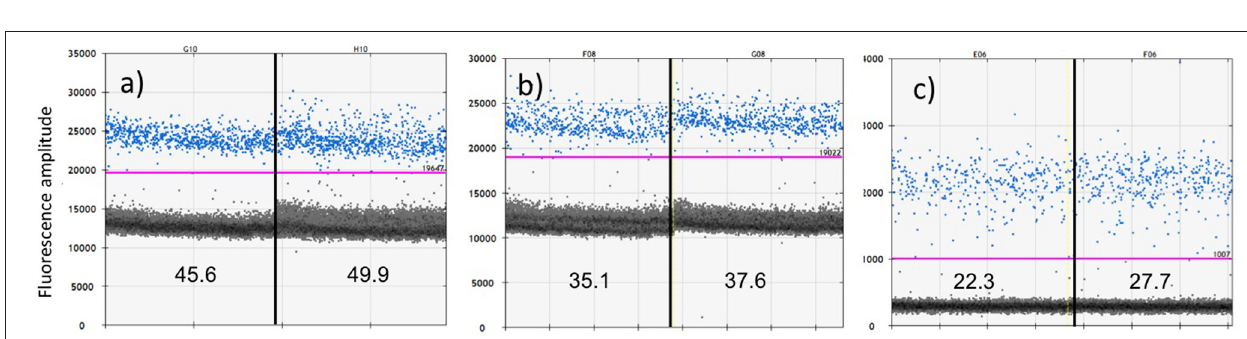
FIGURE 3 | Comparative sensitivity of ddPCR in quantifying a positive control for cetacean mtDNA using three protocols: (a) primers Oordlp6.5F to dlp8G with EvaGreen fluorescent dye; (b) primers Oordlp5Rleft to dlp8G with EvaGreen fluorescent dye; and (c) a molecular probe (FAM labeled TaqMan) nested within Oordlp5Rleft to dlp8G. The samples were run in replicate, as represented on either side of the vertical lines. The estimated copies/ µ L for each replicate is shown near the bottom of each figure. The y axis shows units of amplitude for the fluorescent signal. The estimated copies/ µ L of DNA are measured by the number